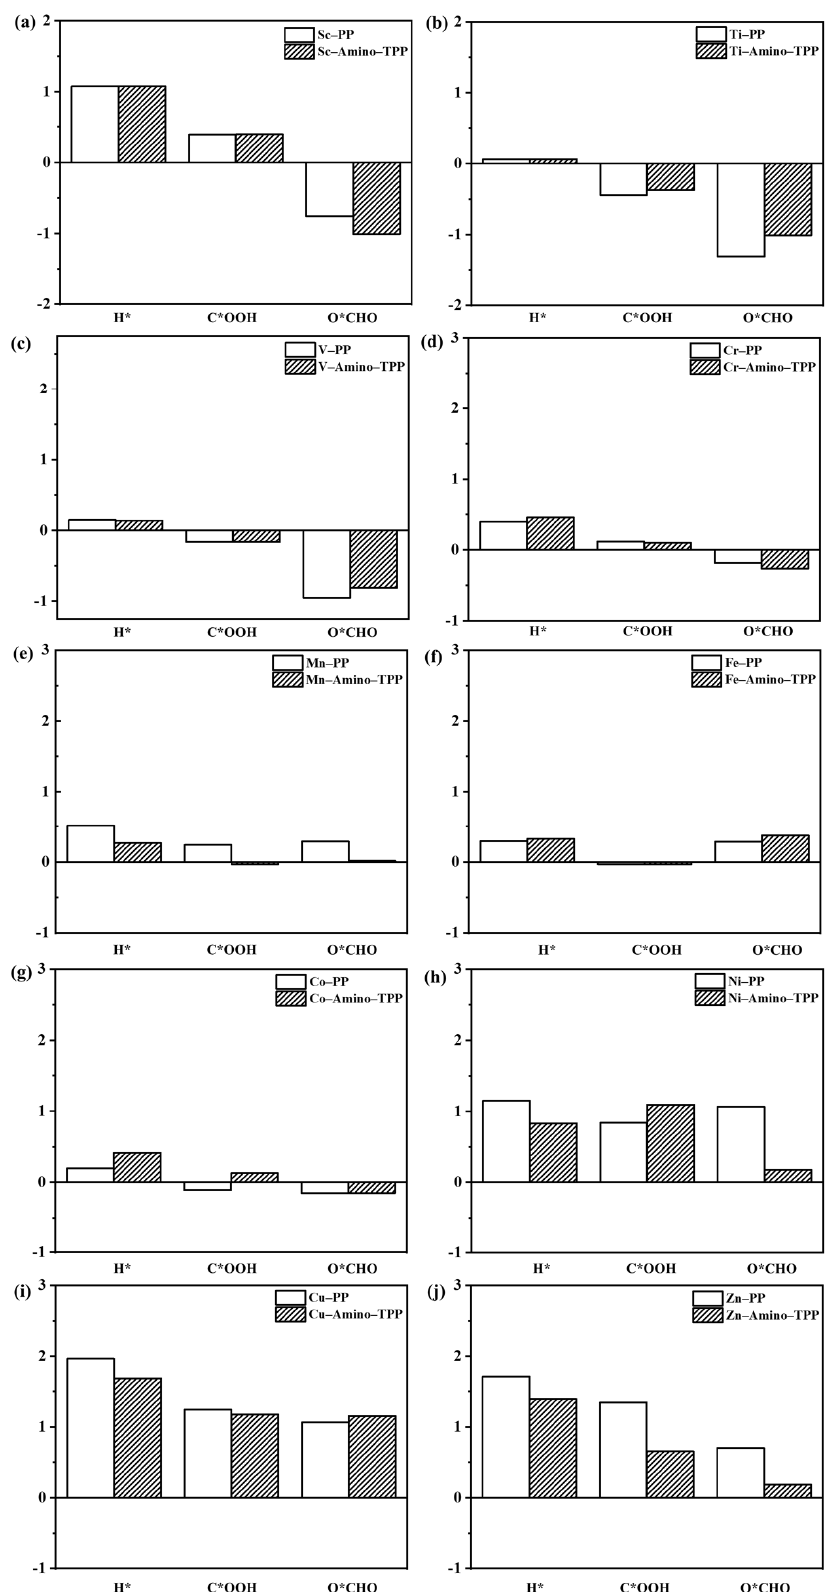
Figure 7. A comparison between the Gibbs free energies of the reaction intermediates for the TM–PPs and TM–Amino–TPPs, where TM is ( a ) Sc, ( b ) Ti, ( c ) V, ( d ) Cr, ( e ) Mn, ( f ) Fe, ( g ) Co, ( h ) Ni, ( i ) Cu and ( j ) Zn.